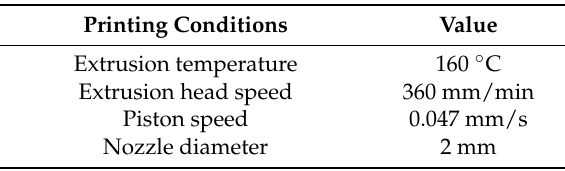
Table 5. Printing conditions in this